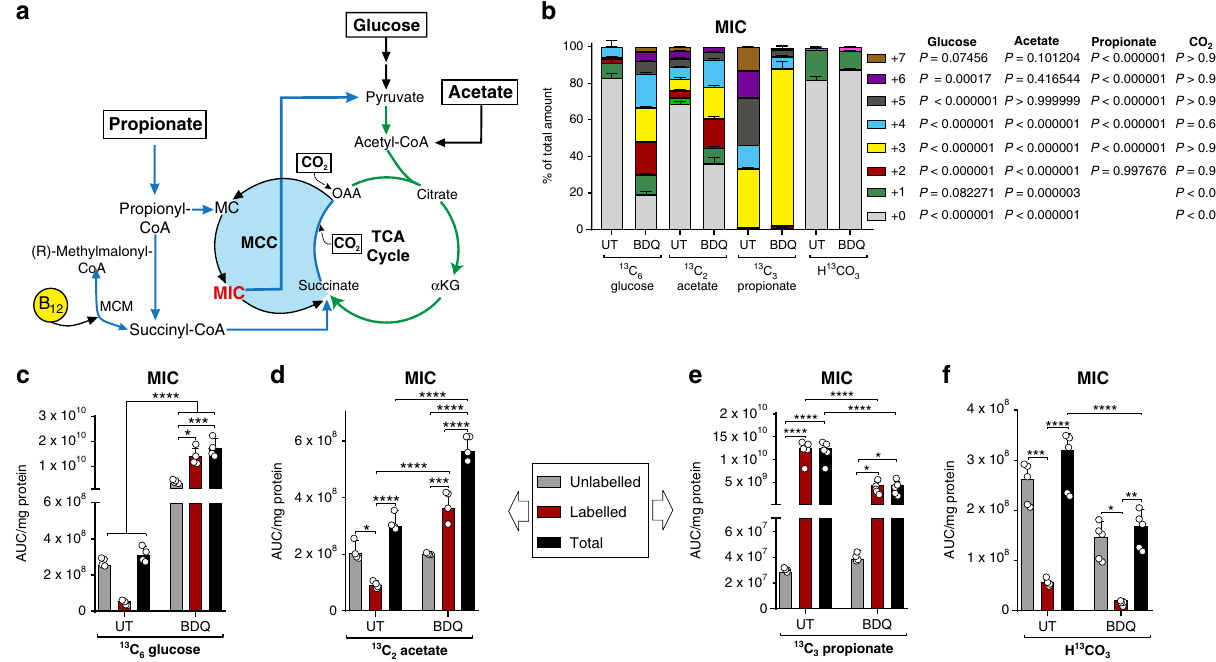
Fig. 5 BDQ exposure dysregulates the MCC. Here we show ( a ) the methylcitrate cycle (MCC) and ( b ) carbon isotopologue distribution (CID), as well as the total levels of methylisocitrate (MIC) from ( c ) 13 C 6 glucose, ( d ) 13 C 2 acetate, ( e ) 13 C 3 propionate and ( f ) 13 CO 2 as the 13 C tracer. Standard error of the mean of at least three replicate extracts is indicated. One representative experiment is shown, with the experiment being repeated a minimum of two times. A two-way ANOVA and Tukey multiple-comparison test were used for the statistical analysis. Mean + / − standard error of the mean (SEM) of at least three replicate extracts is indicated. MCM - methylmalonyl-CoA mutase, UT - untreated, BDQ - bedaquiline. n = 4 biologically independent